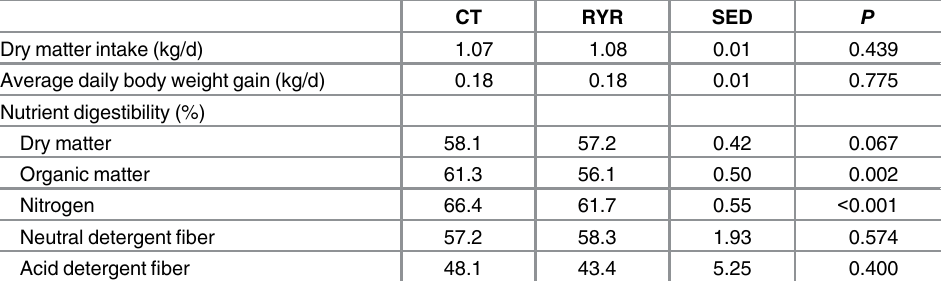
Table 2. The effect of replacement of ordinary rice with red yeast rice on DM intake and apparent nutri- ent digestibility in goats (n = 20). CT RYR SED